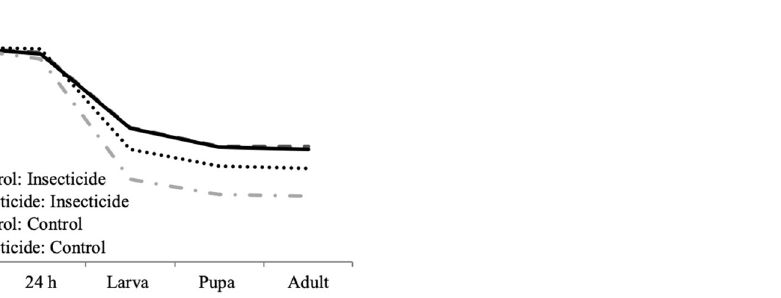
( δ 52 ). Total larval survival was on average 1.75 times higher for beetles descending from the insecticide-exposed mothers when compared to those produced by the control mothers (Fig. 3). Survival in the pupal stage was not affected by the within- ( δ 23 ) or by the within- and transgenerational insec- ticide exposure interaction ( δ 53 ). However, transgenerational insecticide exposure ( δ 33 ) increased pupal survival on average 1.79 times ( δ 33 ) when compared to those in the control group. Adult survival between 0 and 14 days was not so clearly affected by the within- ( δ 24 ) or transgenerational insecticide exposure ( δ 34 ). the second generation. Development time (i.e. days, from egg date until adult emergence; log-transformed